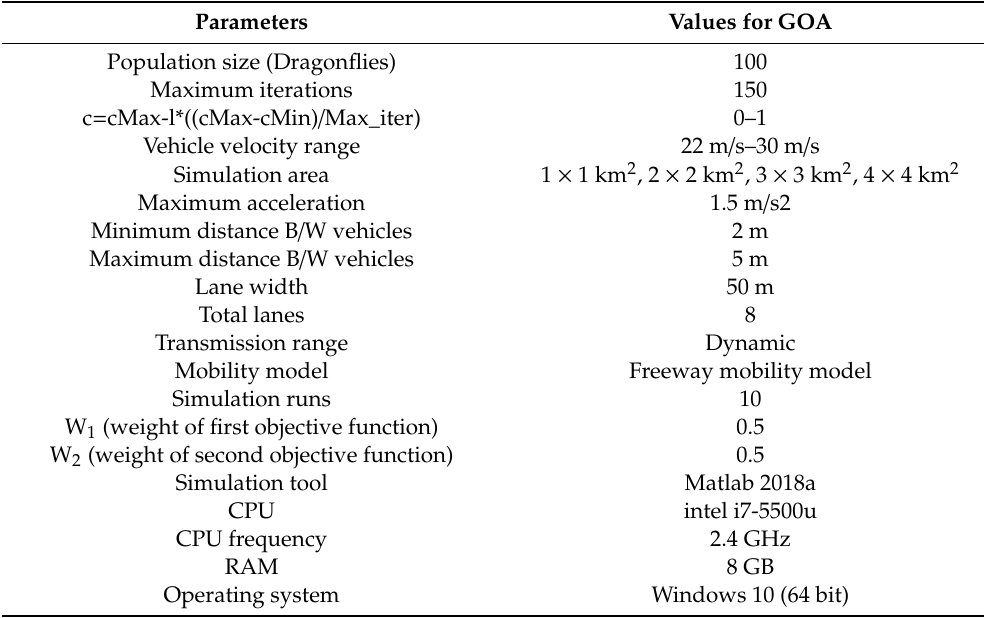
Figure 5. The number of clusters vs. Tx range for 1 Km 2 × 1 Km 2. Table 1. Simulation